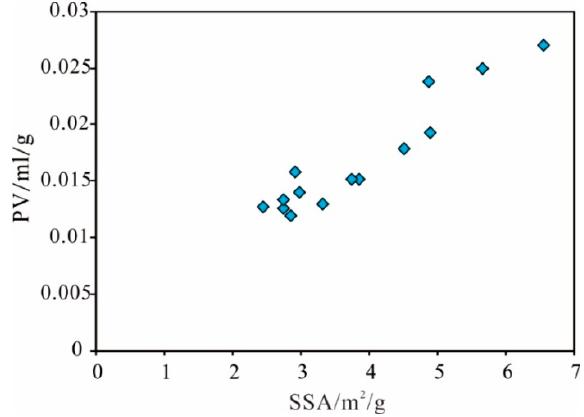
Figure 5. The positive relationship between pore volume (PV) and specific surface area (SSA).